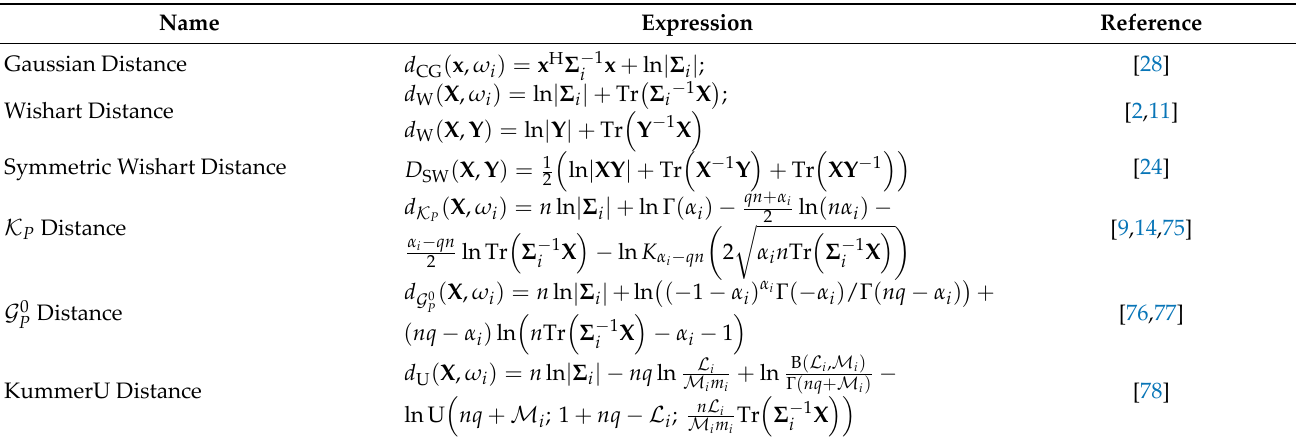
Table 3. Typical ML distances for PolSAR image